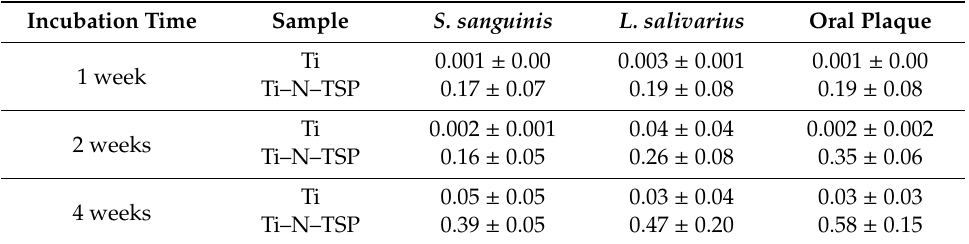
Table 5. Ratio of dead/live bacteria [red cells/(red cells + green cells)] for the different times of incubation at 37 °C (mean ± standard deviation (SD)).